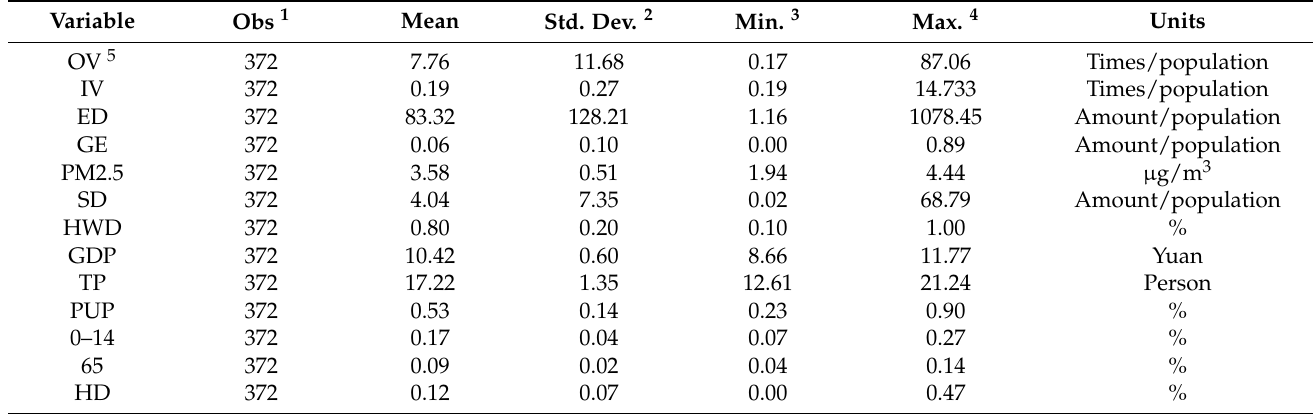
Table 3. Descriptive statistics of the